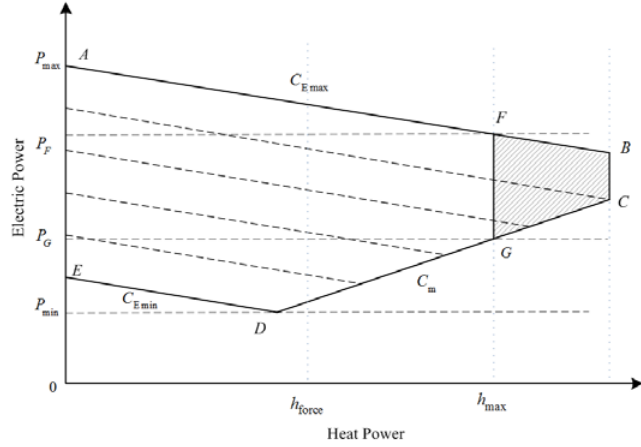
Figure 1. Thermal-electric coupling relationships of extraction turbo-generator unit.